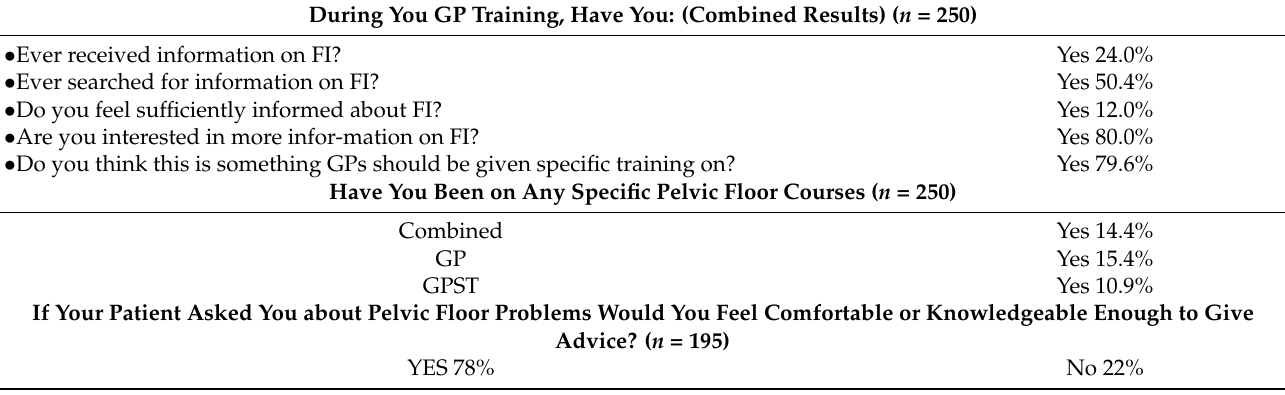
Table 2. Faecal incontinence education.